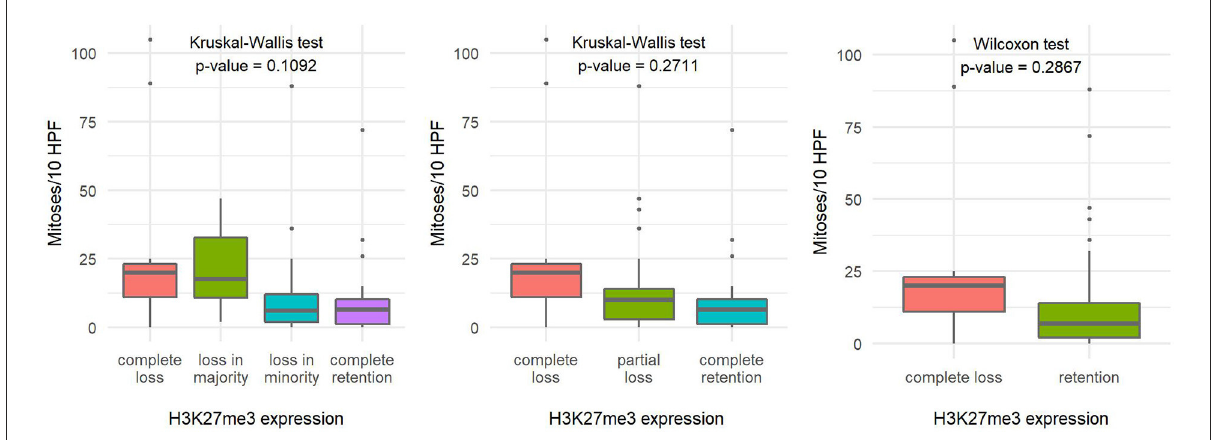
FIGURE4 Comparison of the number of mitoses per ten high-power fields based on H3K27me3 expression using a 4-tier scoring scale (A) , a 3-tier scoring scale (B) , and a 2-tier scoring scale (C) , indicating the statistical test used and the corresponding p -value.